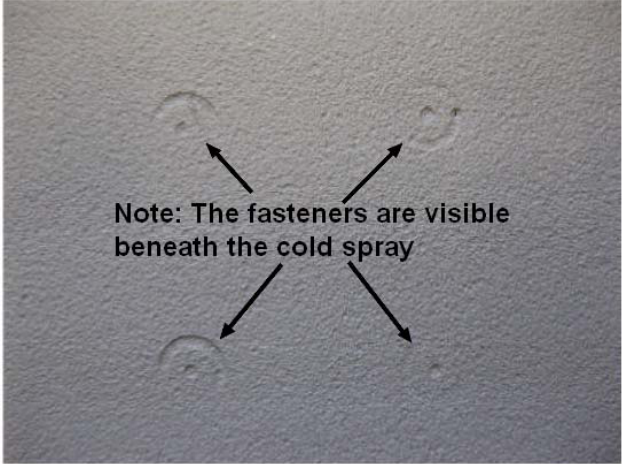
Figure 17. A close up view of a cold spray repair over fasteners; from [93].